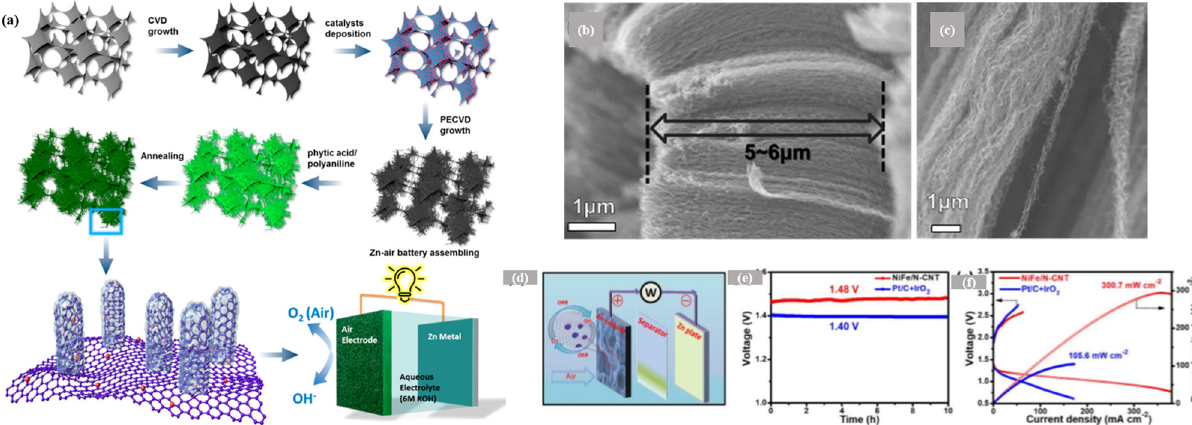
Figure 11: ( a ) Synthesis process of NP - VACNTs - GF samples. Morphological characterization diagram of VACNT - GF: ( b ) SEM images of VACNT - GF at low magni fi cation. ( c ) SEM images of VACNT - GF at high magni fi cation [ 78 ] . Copyright 2019, American Chemical Society. ( d ) Schematic of the Zn – air battery. ( e ) Open - circuit plots of Zn – air battery based on the NiFe/N - VACNT catalyst. ( f ) Charge – discharge polarization curves and the corresponding power density [ 76 ] ; Copyright 2015,